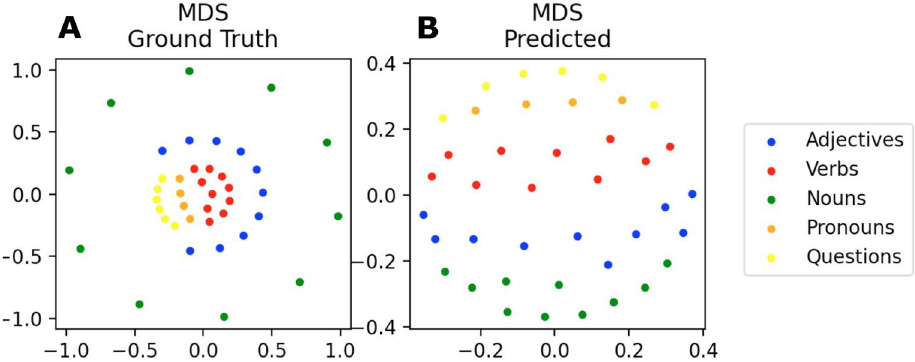
Figure 9. MDS of the word successor representation vectors: a two-dimensional projection of the 40-dimensional word SR vectors (rows in SR matrix) for the calculated ground truth ( A ) and the learned SR matrix ( B ). In both cases, the words cluster according to the respective word class. Different colors correspond to word classes again. However, the resulting clusters are less dense and located closer to each other than for the TP vectors. Since SR vectors cover several time steps, whereas TP vectors only cover a single time step in the future, this result is intuitive. Note that, scaling of the axes is in arbitrary units since coordinates have no particular meaning other than indicating the relative positions of the projected